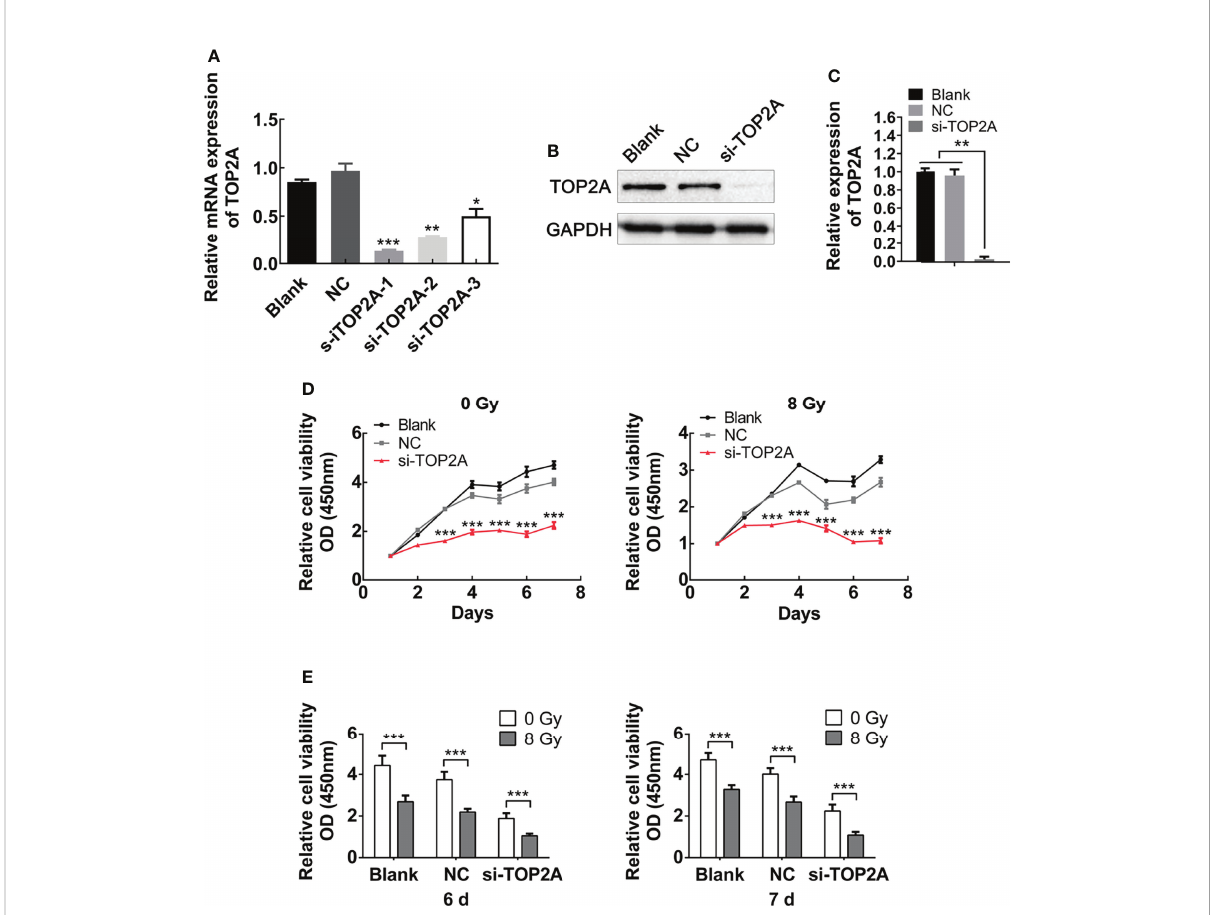
FIGURE 5 Downregulation of TOP2A inhibits MB cell proliferation. (A) The expression of TOP2A was detected by RT-qPCR after transfecting Daoy cells with TOP2A siRNAs. *P<0.05, **P<0.01, ***P<0.001. (B) The expression of TOP2A was detected by western blot analysis after transfecting Daoy cells with si-TOP2A. (C) Semi-quantitative densitometric analysis was used to measure the relative levels of TOP2A. **P<0.01. (D) CCK-8 assay was used to detect the proliferation ability of si-TOP2A-transfected MB cells with or without exposure to 8 Gy IR. ***P<0.001. (E) The relative proliferation of si-TOP2A-transfected MB cells was shown at days 6 and 7 post IR treatment.